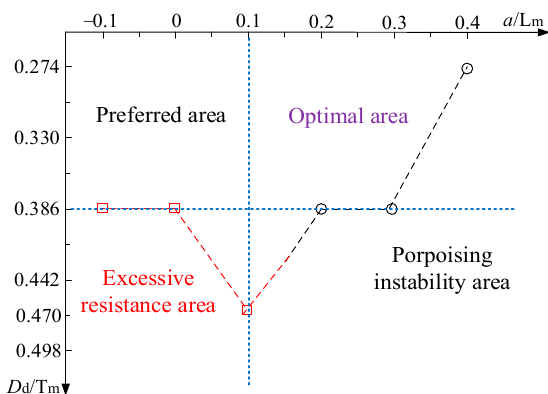
Figure 31. Optimization of longitudinal and vertical side-hull locations on porpoising instability inhibition and resistance reduction.